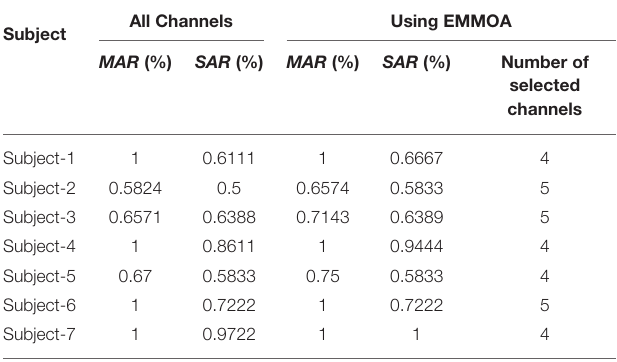
TABLE 5 | Maximum results obtained by all algorithms.